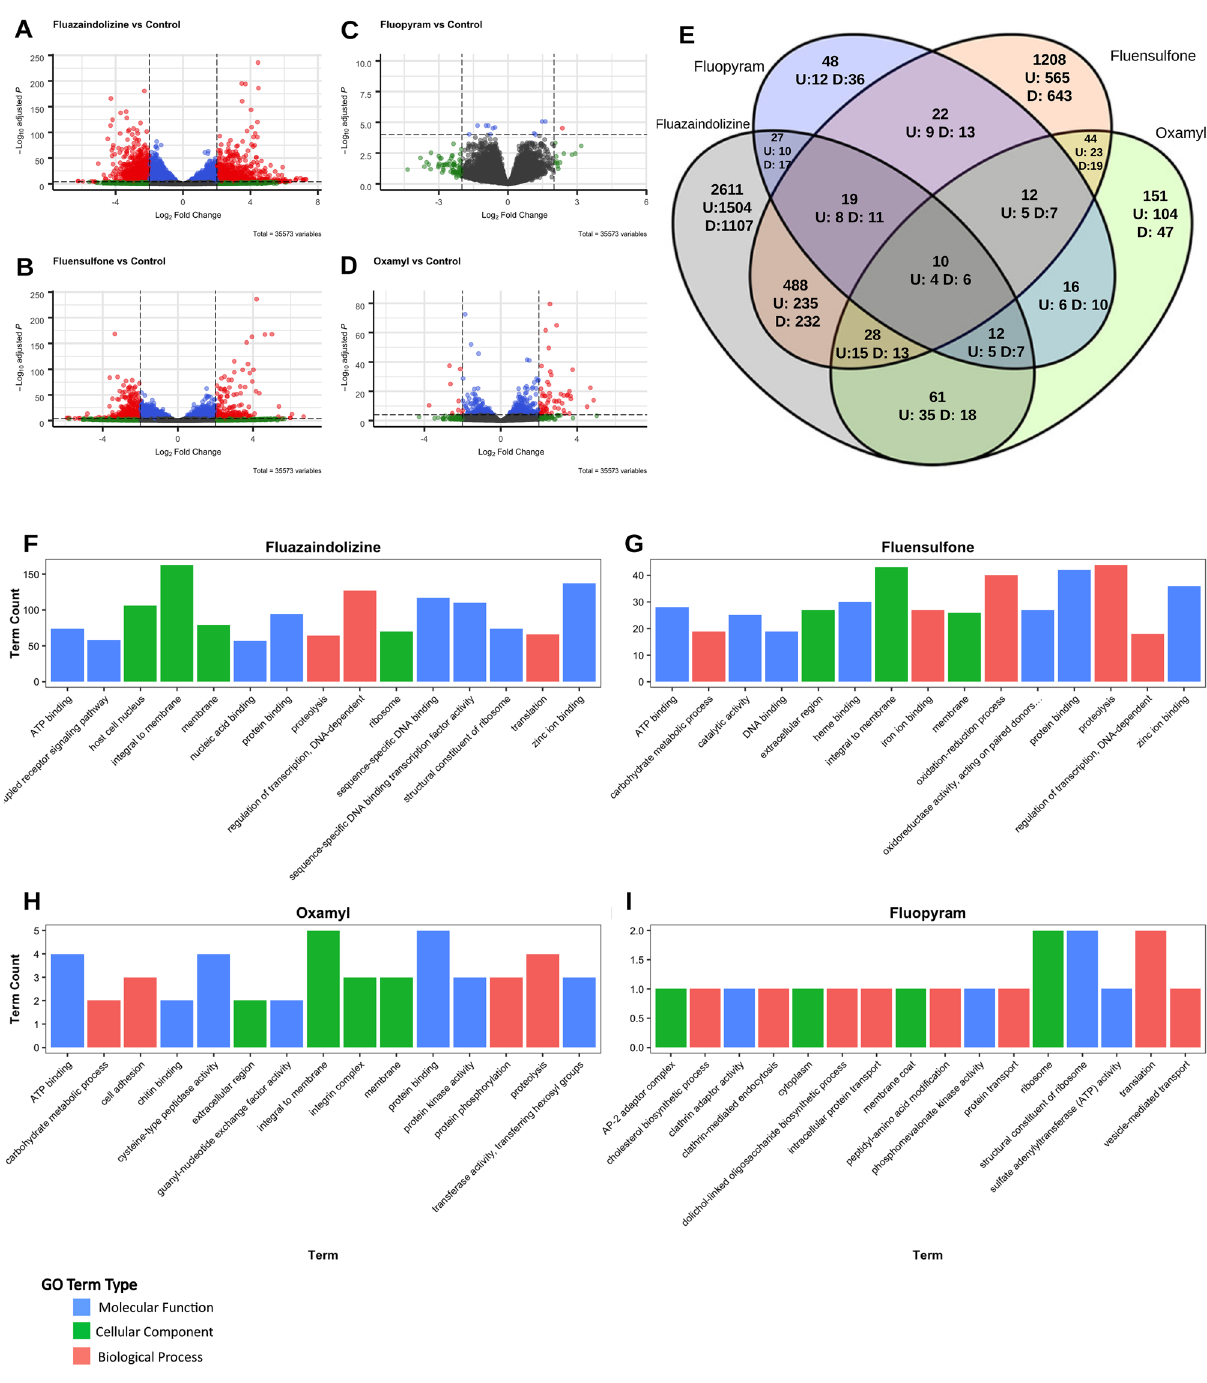
Figure 1. Summary of differentially expressed genes and the top Gene Ontology (GO) terms associated with significantly differentially expressed genes. Meloidogyne incognita second-stage juveniles were exposed to fluazaindolizine, fluensulfone, fluopyram, and oxamyl for 24-h and high throughput sequencing was used to determine gene expression compared to water control (N = 4 replicates/treatment). Volcano plots showing the differentially expressed genes in each treatment of this study ( A – D ). Dashed lines represent Log 2 Fold Change values of − 2 and 2 and the y-axis the − Log 10 of the adjusted p -value. The Venn diagram ( E ) shows the number of overlapping significantly ( p -adjusted value < 0.05) differentially expressed genes between treatments. The number of up- or down-regulated genes, respectively (U and D). The top 15 Gene Ontology (GO) were examined in each treatment ( F – I ). The number of significantly ( p -adjusted value < 0.05) differentially expressed genes in a treatment per a GO term are represented in the bar graphs. Color in each graph indicates the broader GO category each GO term belongs